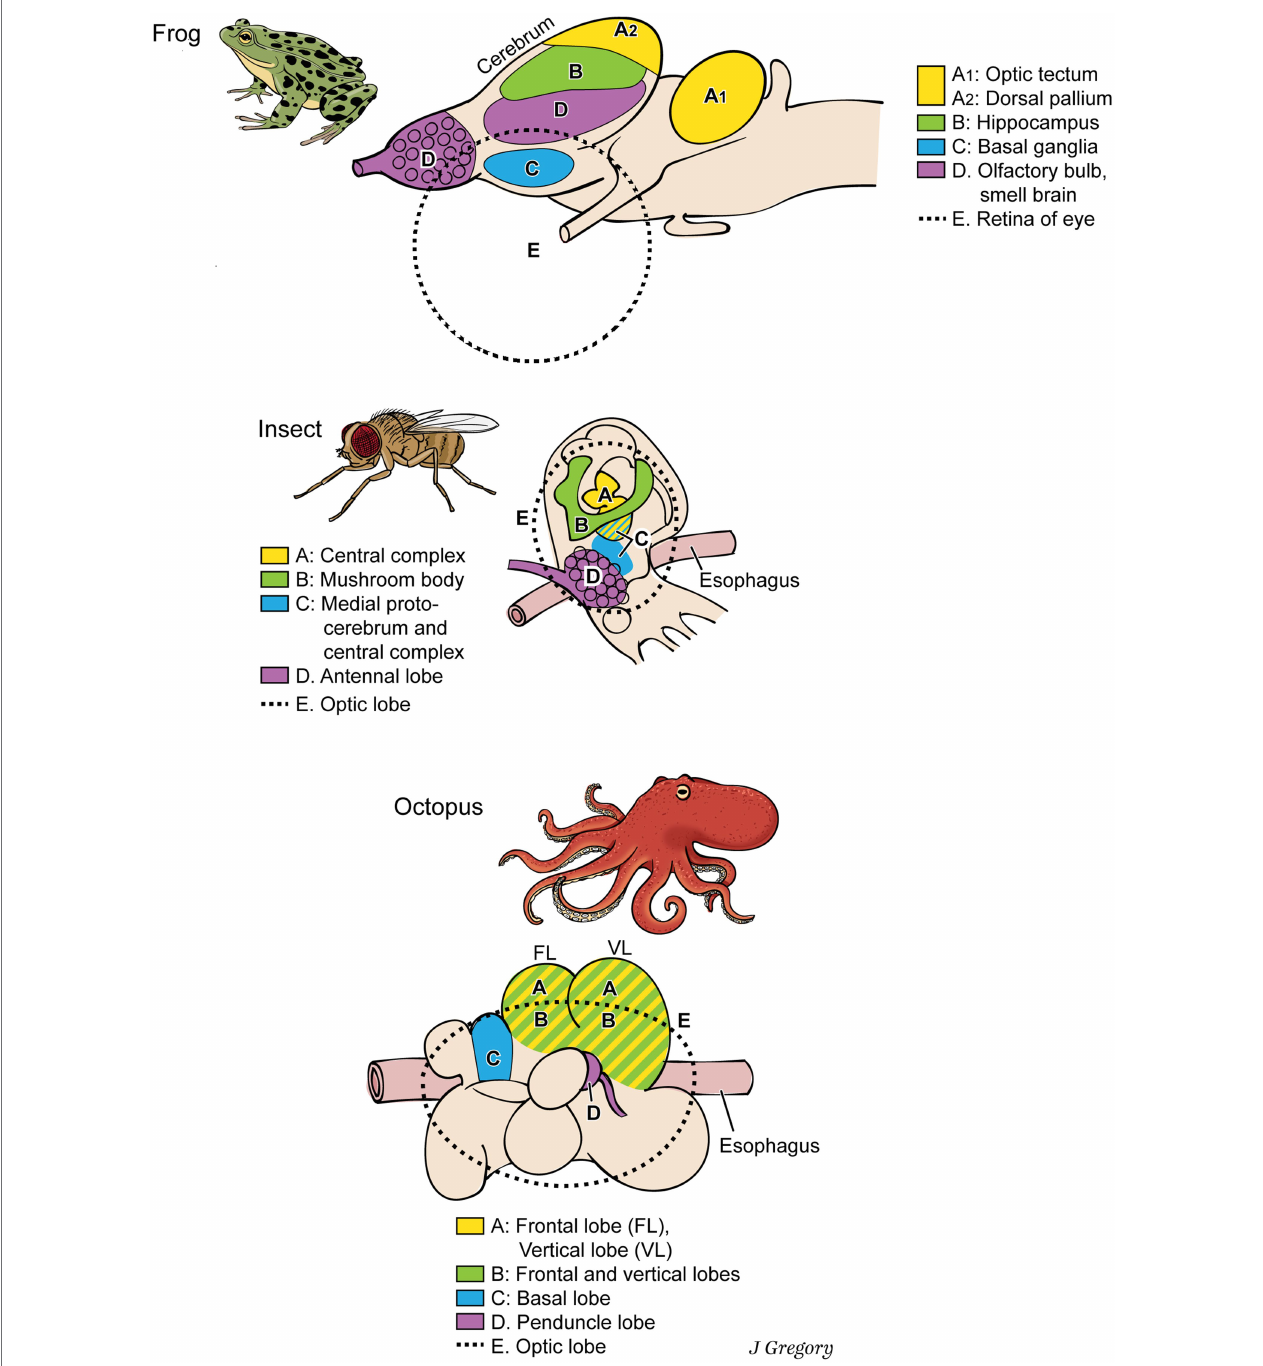
FIGURE 3 | Dissimilar brains of three different taxa of animals with consciousness. The areas with similar functions are colored the same in the different brains. The general code is: (A) , image-based consciousness; (B) , memory; (C) , pre-motor center; (D) , smell processing; and (E) , visual processing. From Consciousness Demystified , MIT, 2018, reproduced with the permission of the copyright holder Mount Sinai Health